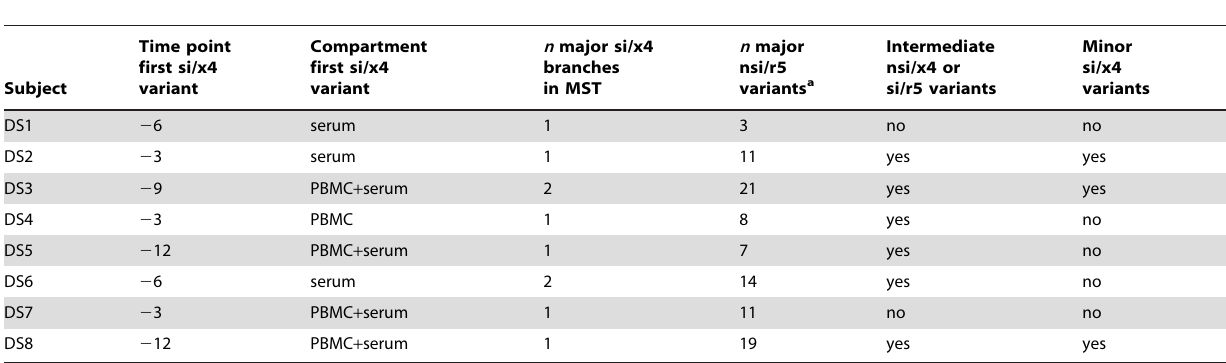
Table 4. Summary of the evolution of nsi/r5 sequences to si/x4 sequences obtained by ultra-deep sequencing.